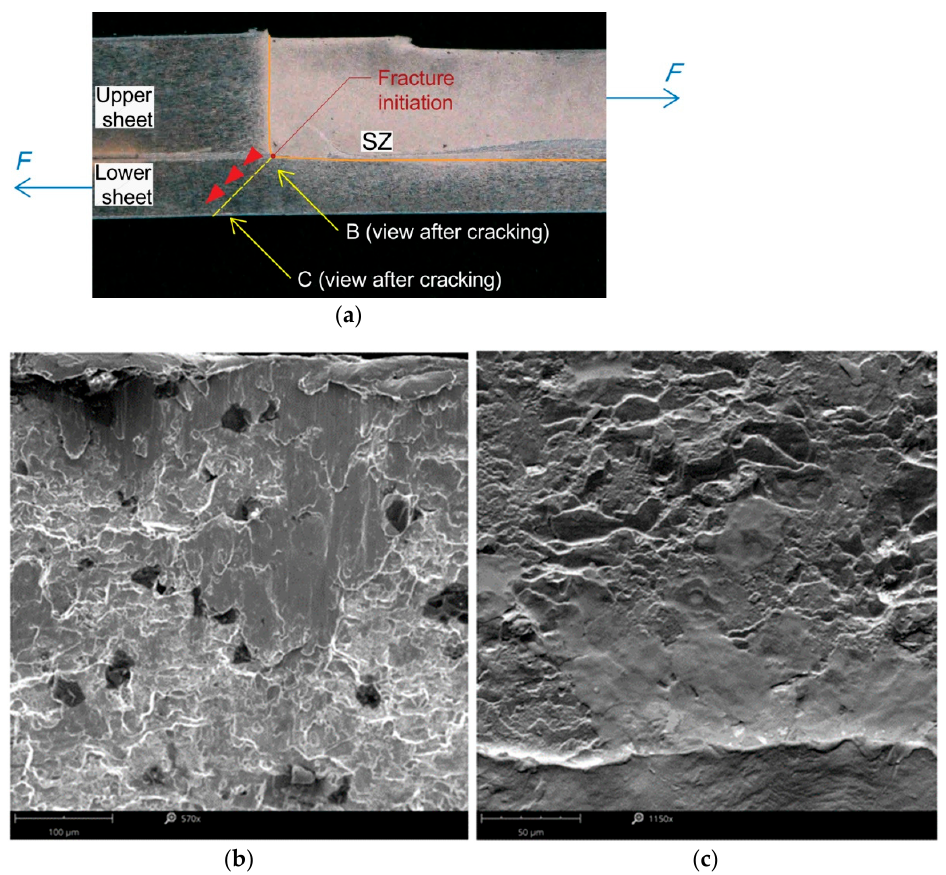
Figure 13. ( a ) Character of the fracture in the lower sheet and ( b , c ) SEM micrographs of the fracture surface in the vicinity of the opposite surfaces of the lower sheet.